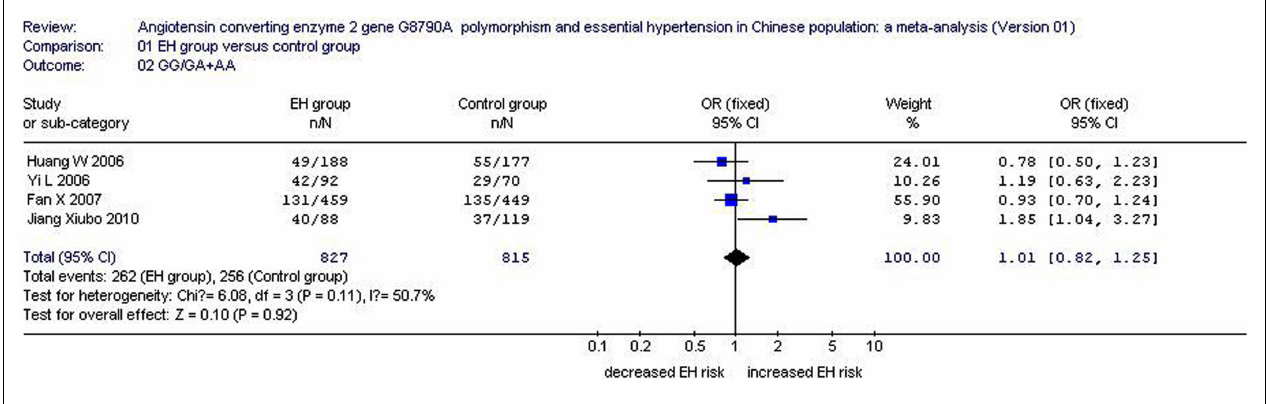
FIGURE 3 | Forest plot of the dominant genetic model of EH associated with ACE2 G8790A gene polymorphism in female population (GG/GA + AA value of angiotensin converting enzyme 2